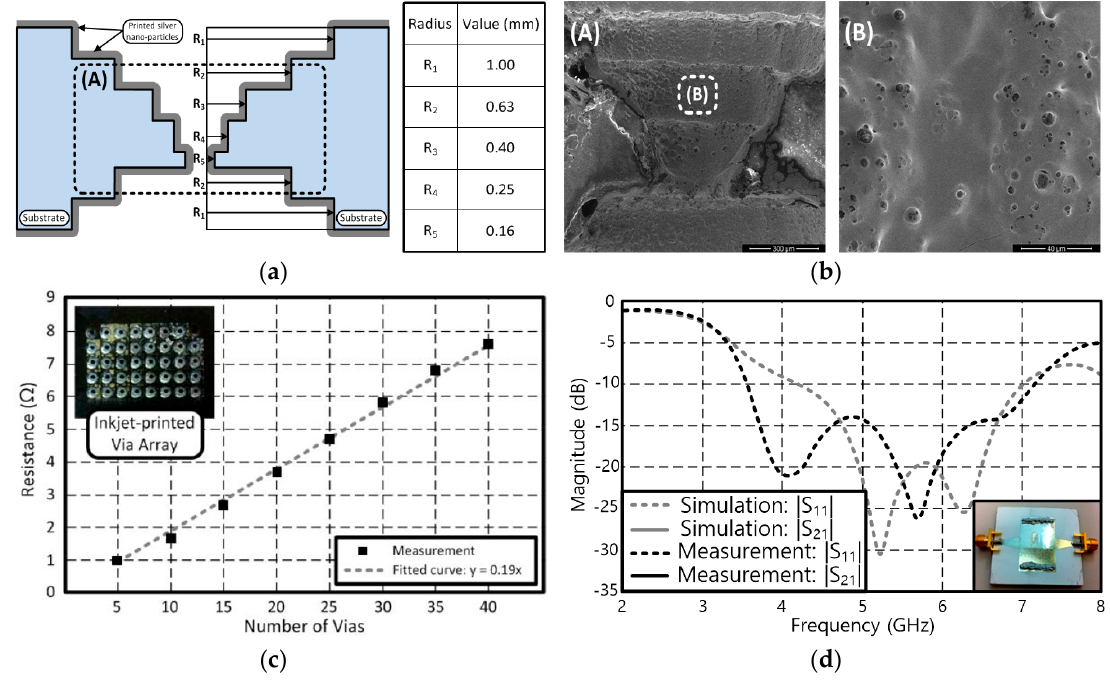
Figure 14. Geometry of a stepped via hole on a polymer substrate (PMMA): ( a ) Cross-section of the stepped via hole; ( b ) SEM images of the fully inkjet-printed stepped via hole; ( c ) series of 40 connected printed stepped vias; and ( d ) microstrip-to-SIW transition with printed stepped via